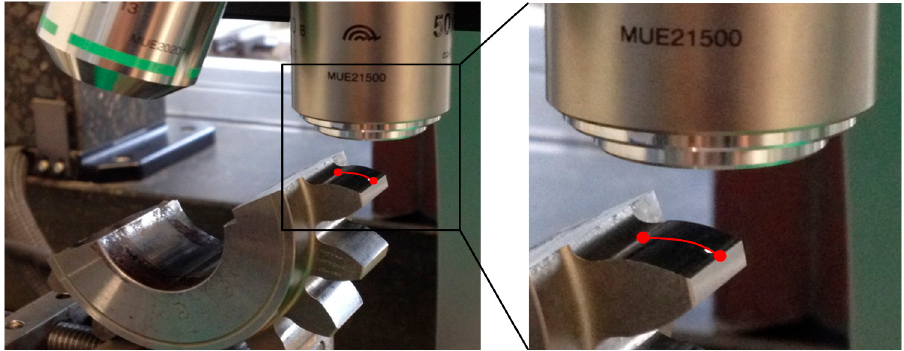
Figure 3. Tooth flank surface documentation of the pinion with an autofocus measuring device.